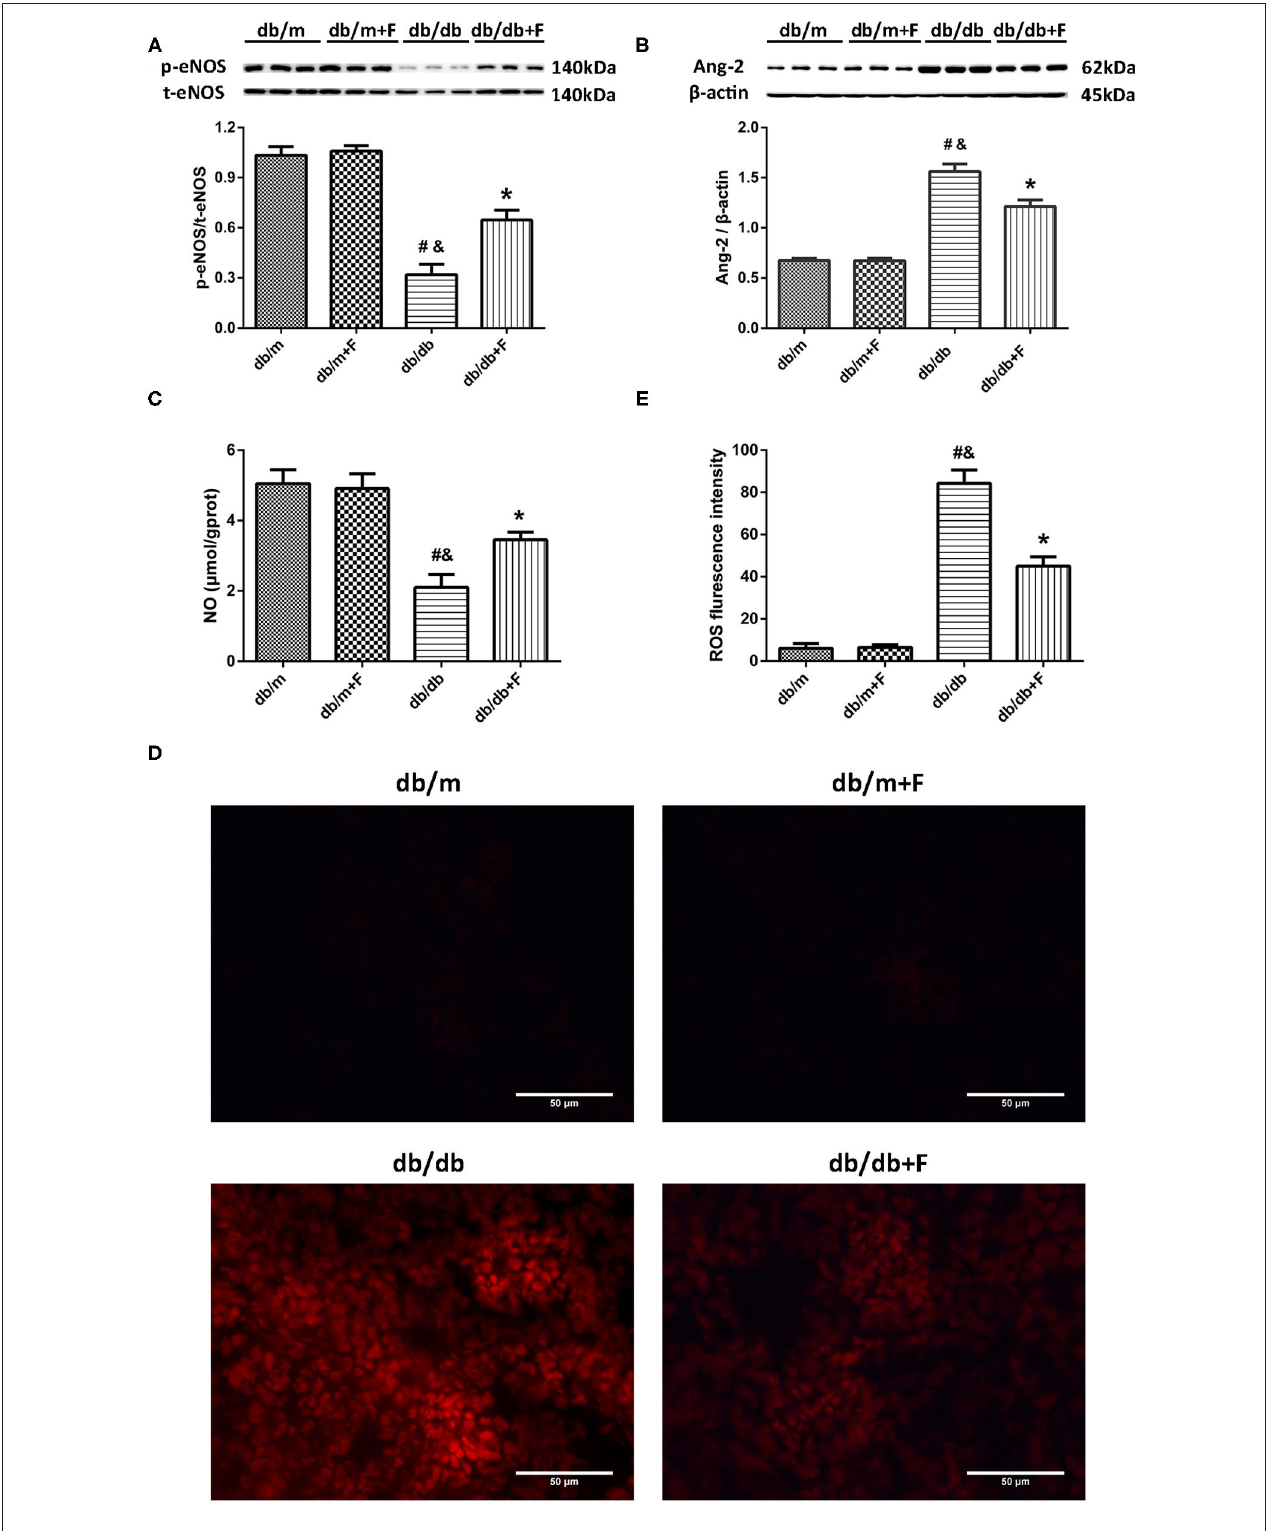
FIGURE 5 | Endothelial function in mouse kidneys. (A) Representative photographs and quantification of phospho-endothelial nitric-oxide synthase (p-eNOS)/total-endothelial nitric-oxide synthase (t-eNOS) in mouse kidneys measured by western blot. (B) Representative photographs and quantification of angiopoietin-2 (Ang-2) in mouse kidneys measured by western blot. (C) Quantification of nitric oxide (NO) level in mouse kidneys measured by Griess. (D,E)